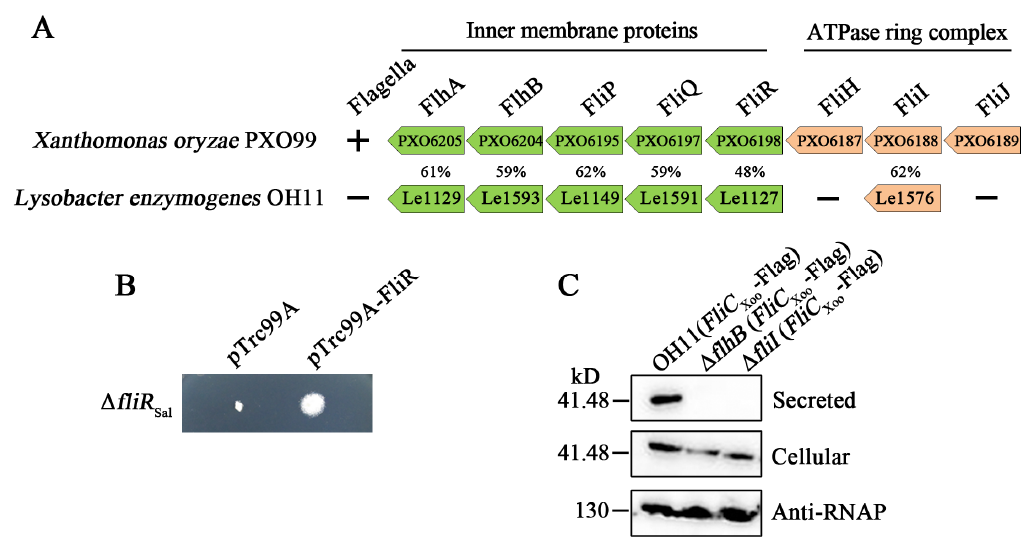
Figure 1. The non-flagellated Lysobacter enzymognes OH11 likely carried a functional flagellar type III apparatus (FT3SS) that was able to mediate the export of heterologous flagellar protein. ( A ) Presence of flagellar type III protein apparatus (FT3SS) homologs in the non-flagellated Lysobacter enzymogenes OH11. The FT3SS genes characterized in the flagellated Xanthomonas oryze PXO99A, a closely related species of L. enzymogenes that was used as reference. The sequence similarity between each pair of proteins was provided accordingly. + and − , flagella present and absent, respectively ( B ) The FliR homolog of strain OH11 partially restored the swimming motility of the Salmonella fliR Sal null mutant. The photograph was taken after incubation of the transformed strain at 30 ◦ C for 24 h. ( C ) Secretion of the heterologous FliC Xoo was dependent on the presence of FT3SS genes in strain OH11. The coding gene of FliC Xoo from X. oryzae PXO99A was fused with a Flag-tag and introduced into the wild-type OH11 and two selected FT3SS-defective mutants ( ∆ fllhB and ∆ fliI ). The signal of the FliC Xoo -Flag fusion protein was detected in the culture supernatant (defined as “Secreted”) of wild-type OH11 but not the test mutant strains, while the intracellular presence (defined as “Cellular”) of FliC Xoo -Flag was observed in both wild type and two FT3SS-defective